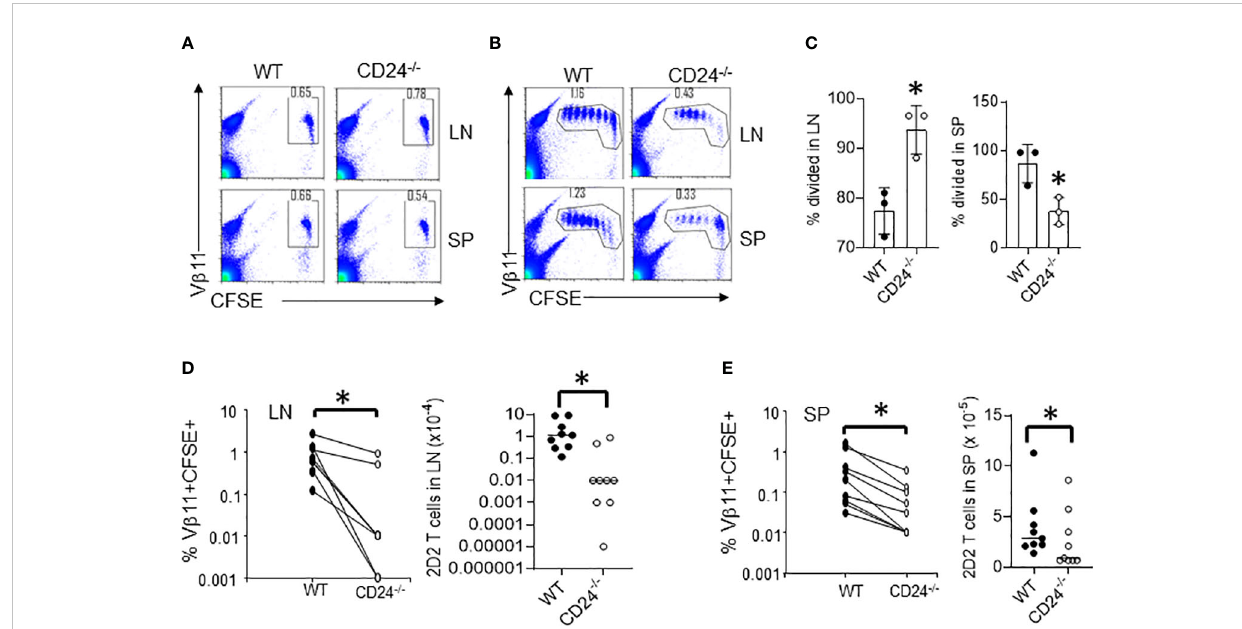
FIGURE 1 Proliferation of 2D2 T cells in CD24-de fi cient mice. CFSE-labeled 2D2 T cells (5 x 10 6 /mouse) were injected into WT or CD24 -/- mice intravenously (i.v.) followed by subcutaneous (s.c.) injection of MOG 35-55 emulsi fi ed in CFA. (A, B) . Percentages of 2D2 T cells (CFSE + V b 11 + ) in draining lymph nodes and spleens of WT and CD24 -/- mice at 17 h (A) and 65 h (B) after immunization were analyzed by fl ow cytometry. Data shown in A-B are representative of eight experiments with similar results. (C) Percent of divided 2D2 T cells in lymph nodes and spleens at 65 h. Representative data from one experiment are shown. (D, E) . Percentages and total numbers of 2D2 T cells in draining lymph nodes (C) and spleens (D) of WT and CD24 -/- hosts at 65 h were quanti fi ed. Data shown in (C, D) were pooled from three independent experiments performed in sex and age-matched mice. SP, spleen; LN, draining lymph nodes. *p<0.05, student ’ s t test was used for the